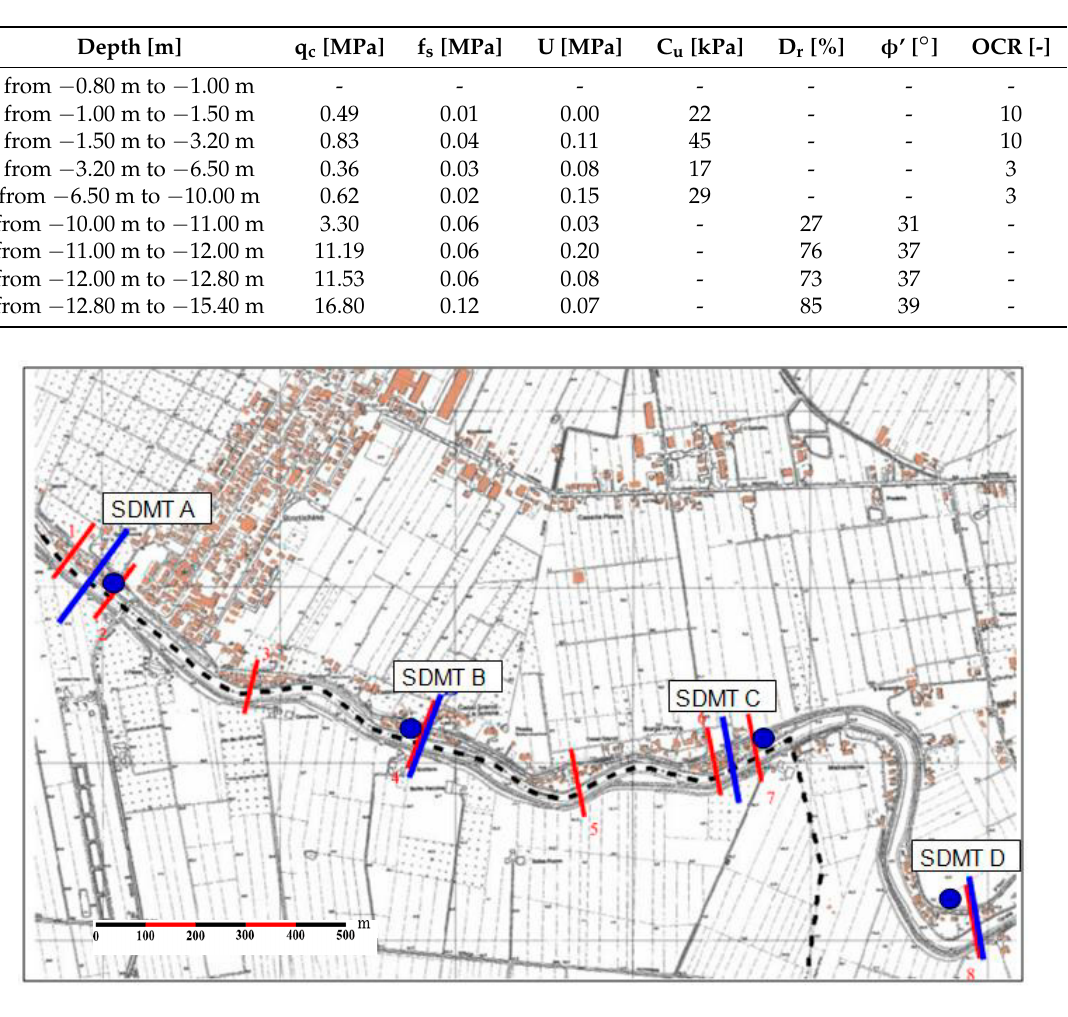
Figure 1. Lay-out of SDMT investigation program. Red lines represent sections along boring locations (8) along the levee; blue lines and blue points represent respectively sections and SDMT tests location in terms of coordinates: SDMT A 44 ◦ 87 (cid:48) 80.4 (cid:48)(cid:48) N 11 ◦ 32 (cid:48) 26.0 (cid:48)(cid:48) E, SDMT B 44 ◦ 87 (cid:48) 38.0 (cid:48)(cid:48) N 11 ◦ 33 (cid:48) 37.9 (cid:48)(cid:48) E, SDMT C 44 ◦ 87 (cid:48) 32.3 (cid:48)(cid:48) N 11 ◦ 34 (cid:48) 62.1 (cid:48)(cid:48) E, SDMT D 44 ◦ 86 (cid:48) 88.7 (cid:48)(cid:48) N 11 ◦ 35 (cid:48) 29.7 (cid:48)(cid:48)